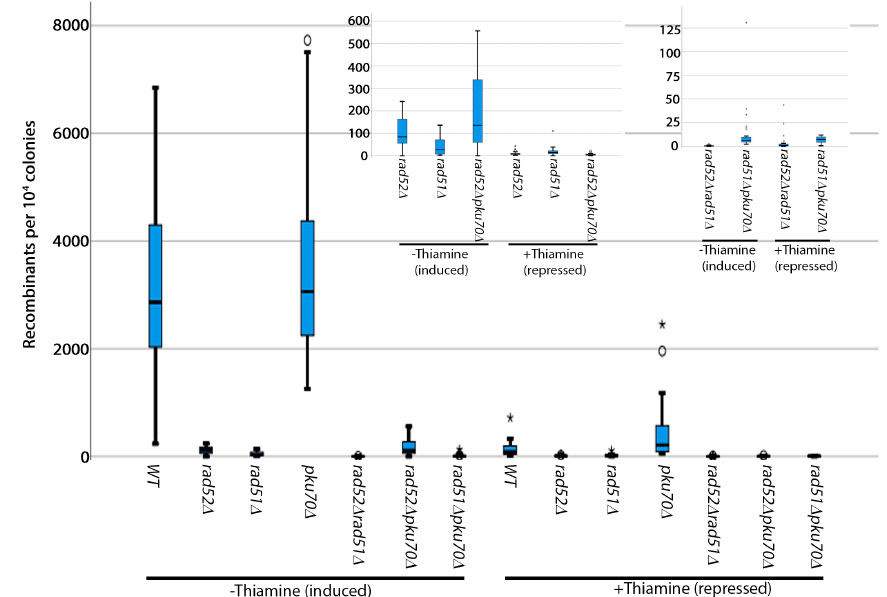
Figure 3. Genetic requirements for induced breaks. Box plots showing the HO -endonuclease-induced recombination frequency per 10 4 colonies. Cells were grown on EMM-Uracil plates for 3–5 days at 32 ◦ C. For clarity, insets are shown for strains with similar recombination frequencies.